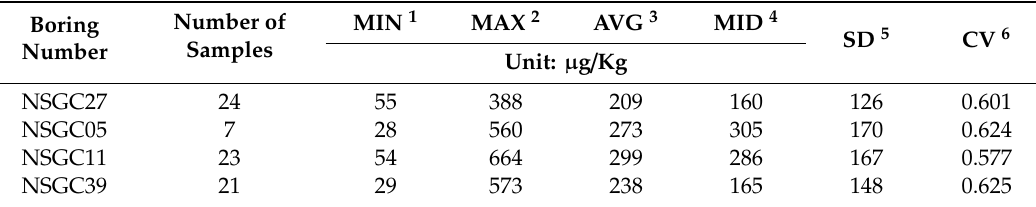
Table 2. Cadmium contents in the di ff erent cores.